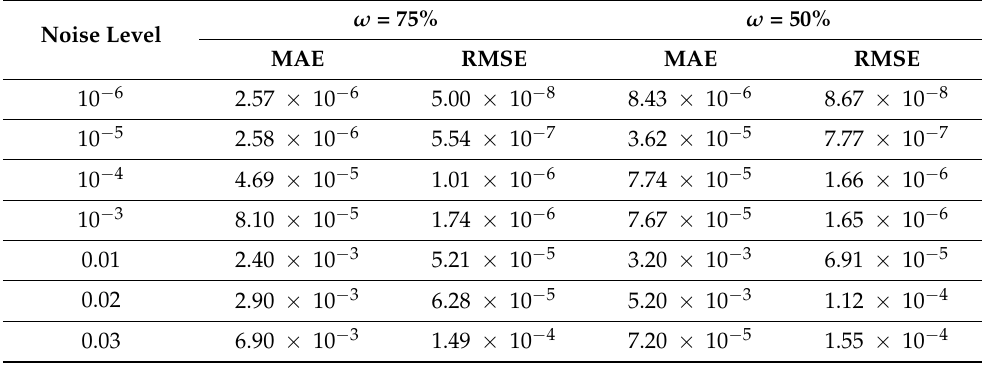
Figure 6. Comparison of results: ( a ) analytical solution, ( b ) numerical solution, and ( c ) MAE. Table 1. Errors of the proposed method with various noise levels.